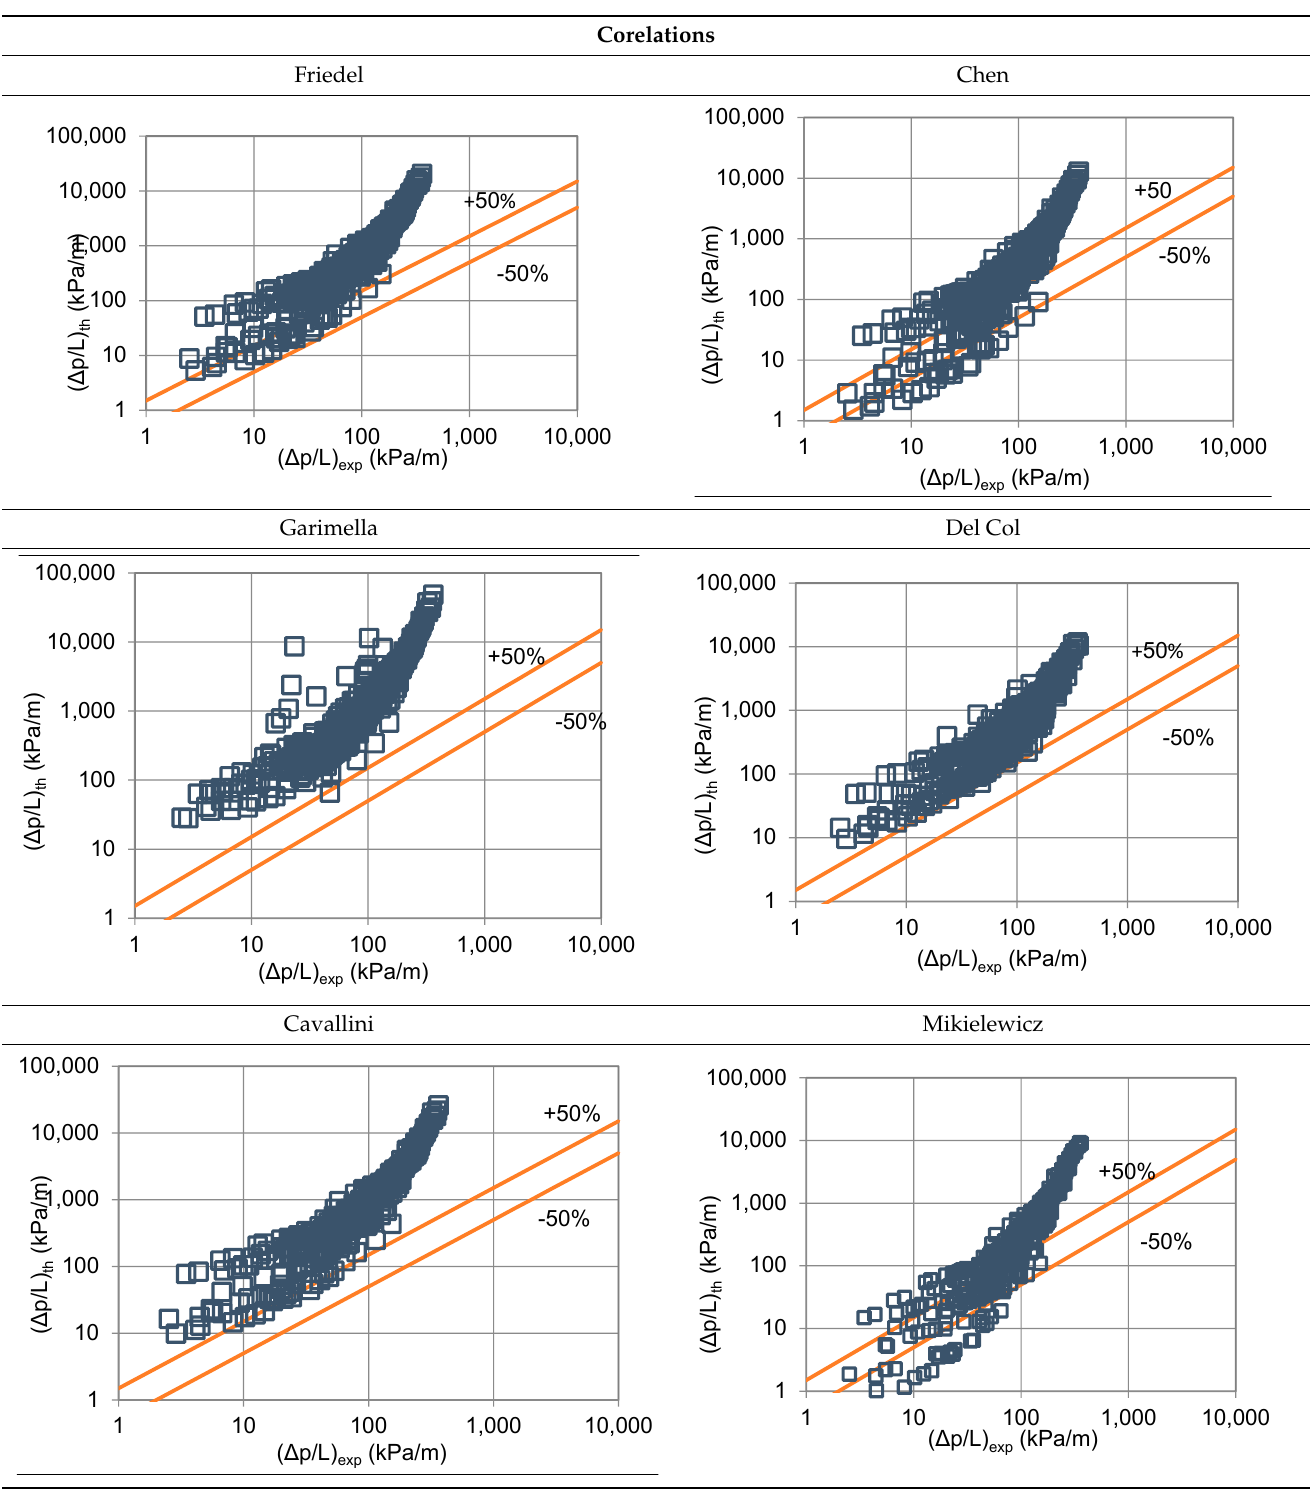
Table 3. Comparison of the pressure drop investigation results with the results of calculations according to the correlations of various authors [9,26–29].